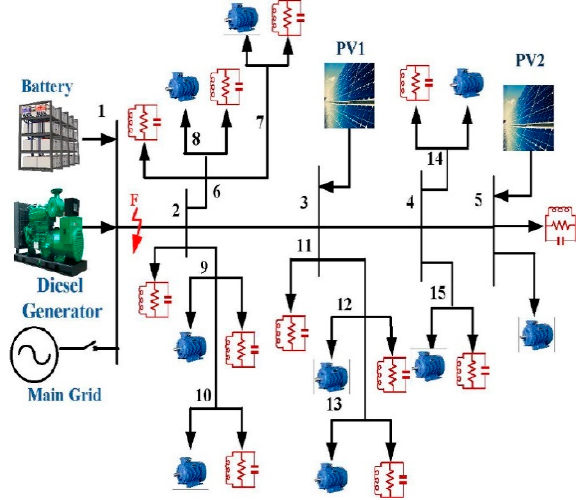
Electronics 2021 , 10 , x FOR PEER REVIEW Figure 12. Case study as a microgrid system for investigating dynamic voltage stability [25].